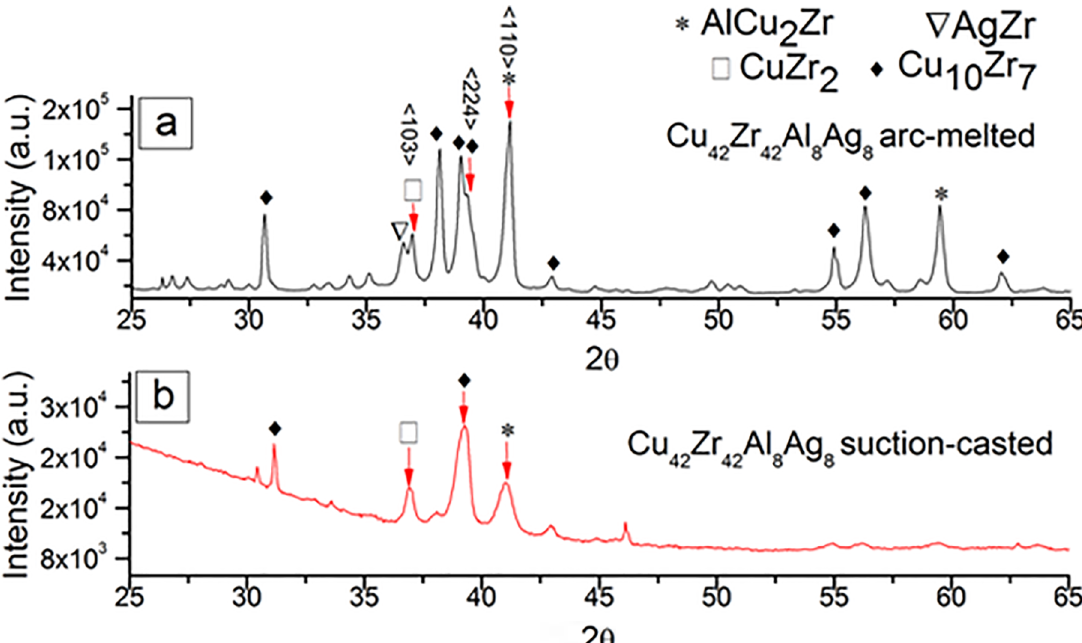
Zr Al Ag , (a) arc-melted and (b) suction-casted. The red arrows indicate the selected peaks for 42 42 8 8